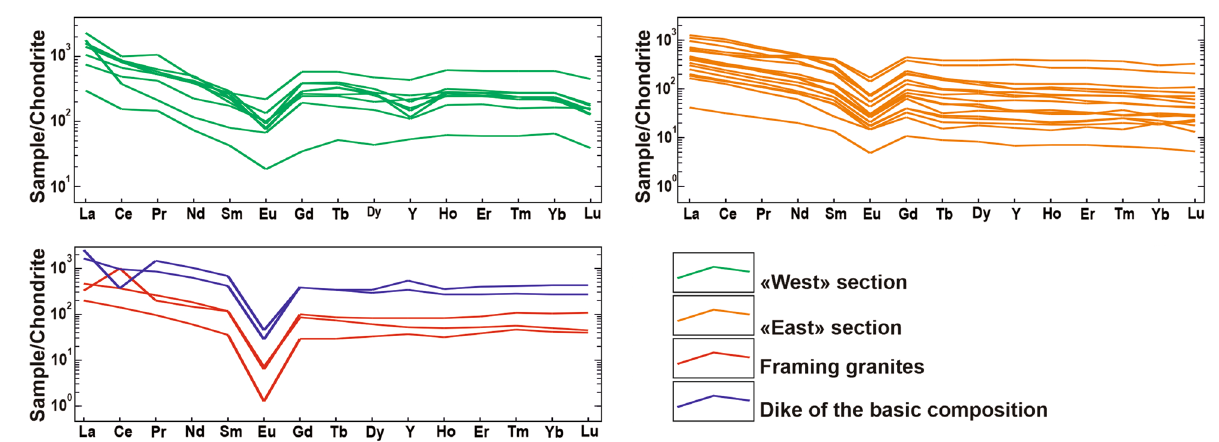
Fig. 4 REE distribution in coal ash, granites, and dike in the Rakovka depression normalized to UCC (Taylor and McLennan